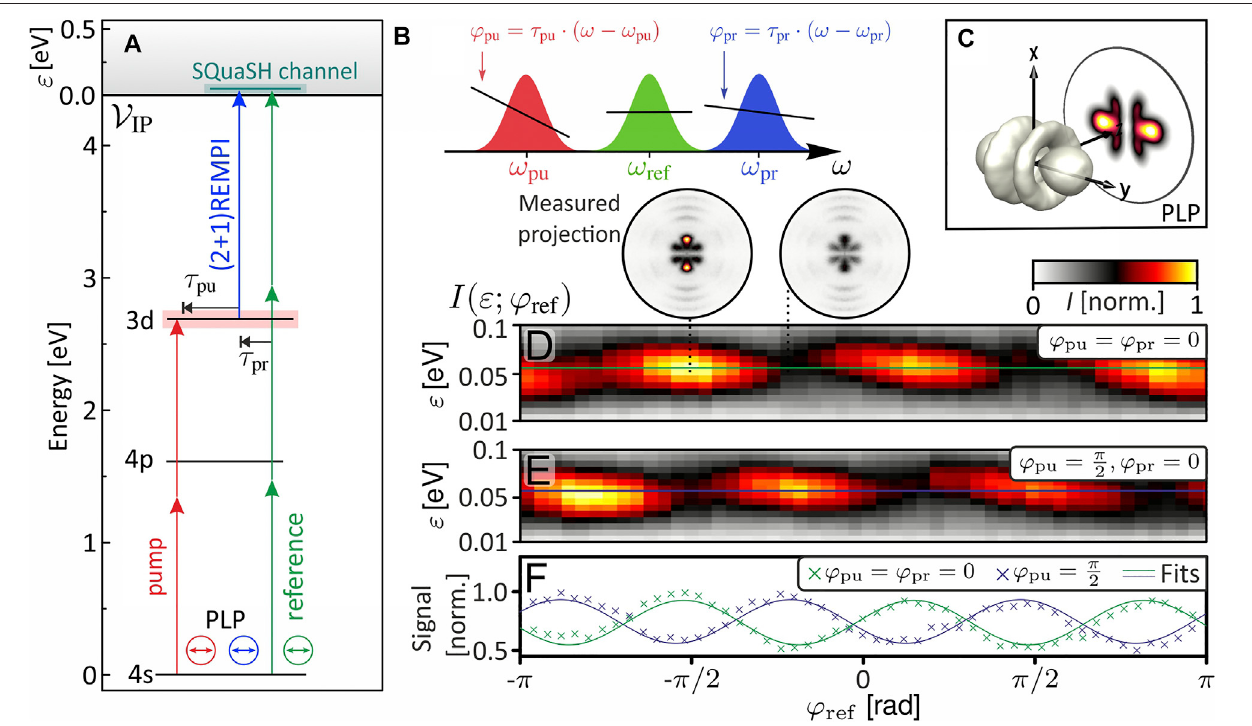
FIGURE13| SQuaSHonpotassiumatomsusingPLPtrichromaticpulsesequences. (A) Excitationschemeforthetwo-photonexcitation(pump)andtime-delayed one-photon ionization (probe) of the potassium 3 d state. Interference of the resulting free electron wave packet with a reference wave packet created by three-photon ionizationofthe ground state bythereferencepulse provides aphase-sensitivephotoelectronhologram inthecontinuum. (B) Thetriple pulse sequence isgeneratedby trichromatic WLS shaping applying linear spectral phases to introduce the time delays of pump and probe relative to the reference pulse. (C) Tomographically reconstructed 3D PMD from SQuaSH with PLP trichromatic pulses. (D) Angularly integrated photoelectron spectra I ( ε ; φ ref ) versus the applied optical phase φ ref of the referencepulse for φ pu (cid:2) 0showingapronounced 2 π -periodicoscillation duetowavepacket interferences. (E) sameas (D) but forarelative phaseof φ pu (cid:2) π ,resultingin 3 2 an inversion of the interference pattern. (F) Sections through (D) and (E) along the phase axis, together with cosine- fi ts, highlighting the cosinusoidal